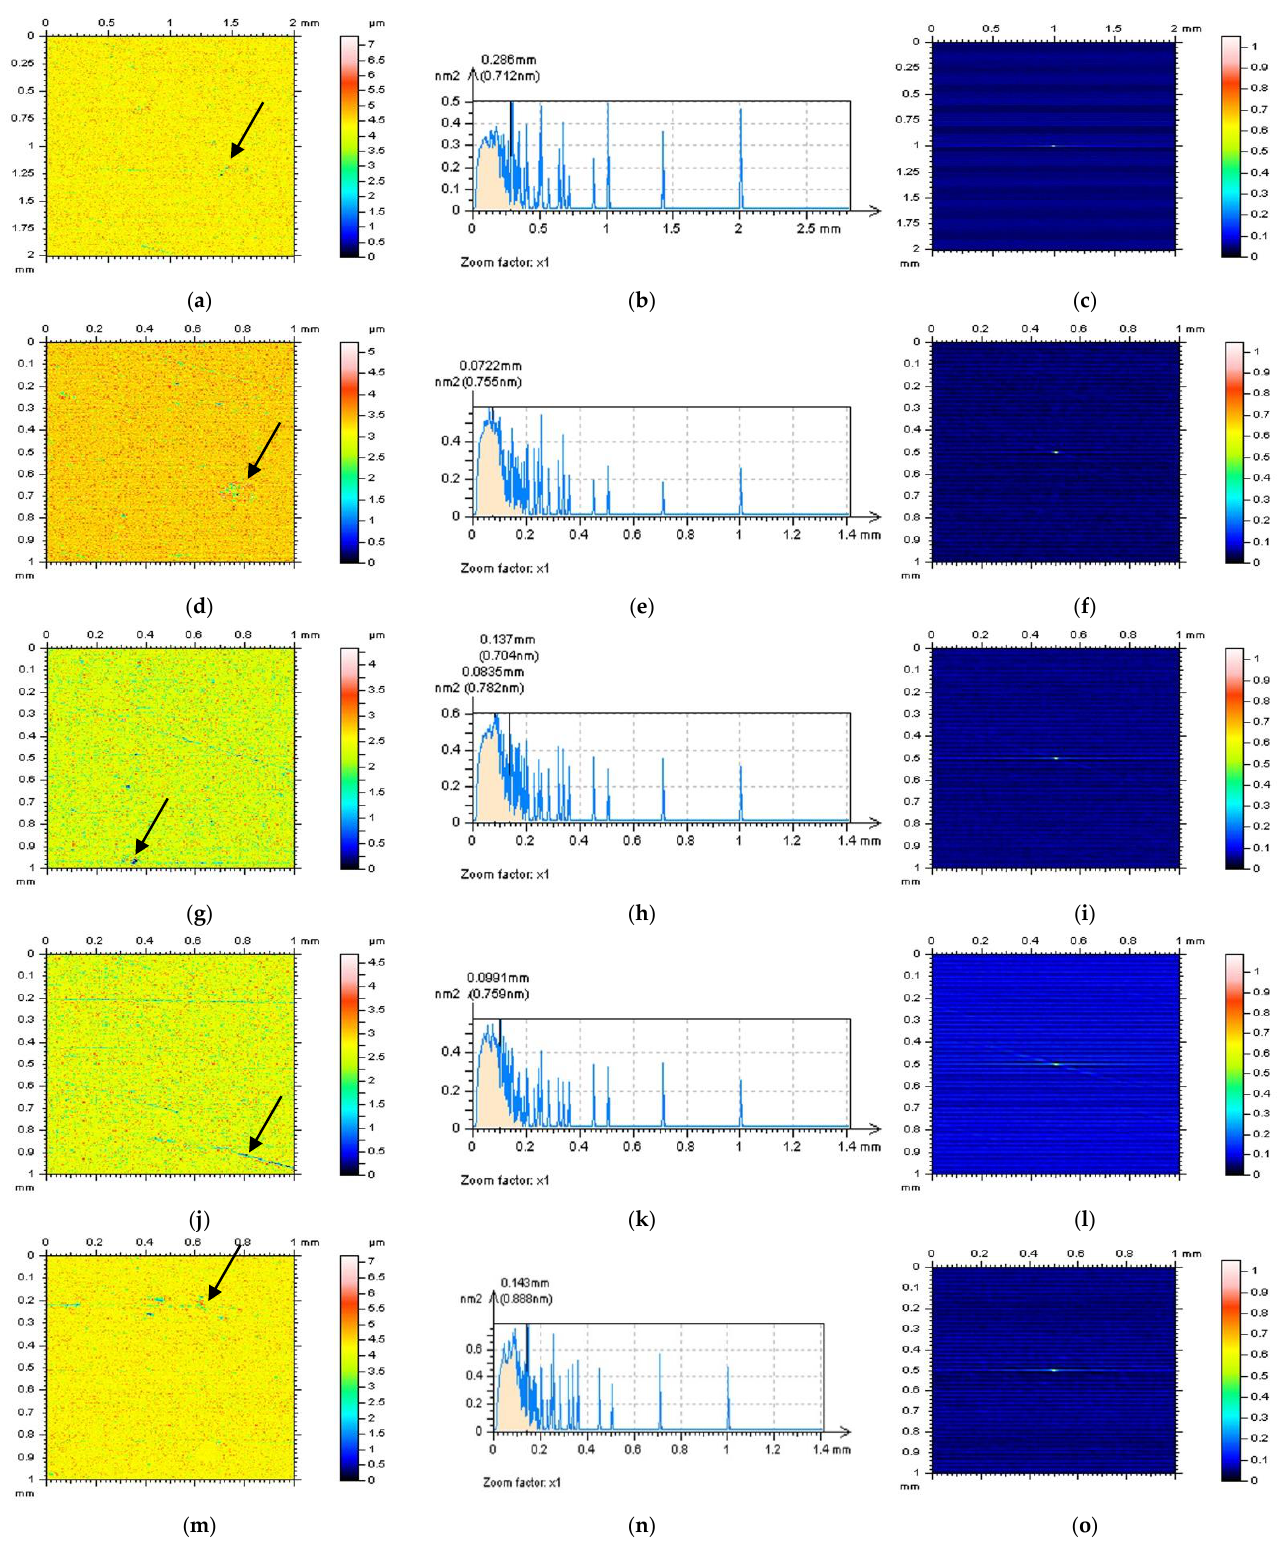
Figure 6. Contour map plots (left column), its 3D PSDs (middle) and ACFs (right column) of NS received by an RGF application (cut-off = 0.015 mm) from the measured surface ( a – c ) and surfaces: E ( d – f ), F ( g – i ), G ( j – l ), and H ( m – o ) extracted from a turned surface. Description of A – D surfaces was presented in the previous figure, Figure 5. Arrows present unwanted features.